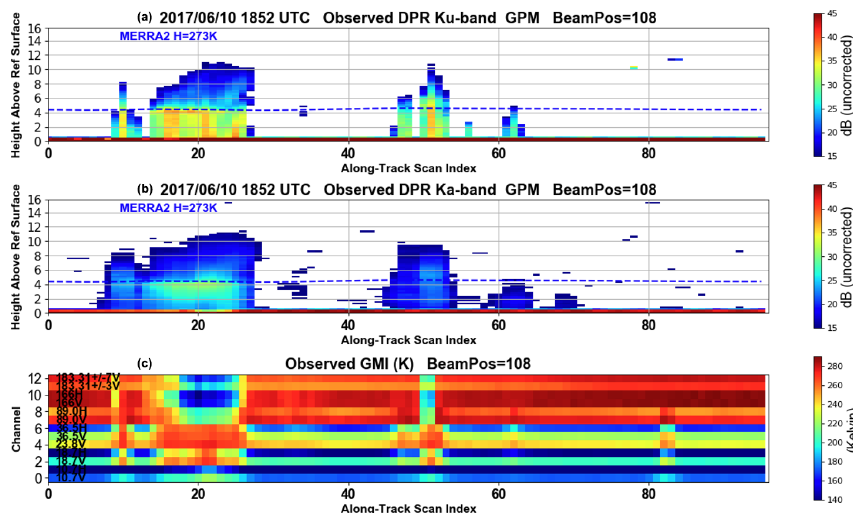
Figure 6. GPM overpass near 18:52UTC on 10 June 2017. (a) DPR Ku-band profile underneath the cross-sectional line indicated in the left panel of Fig. 5. Scan index b0 indicates the northernmost location of the cross section. (b) Same as top panel, but for the DPR Ka-band radar. (c) Trace of each of the 13 GMI channels along this same cross section ordered from the lowest GMI frequency (10.7GHz) to the highest GMI frequency (183.31GHz).